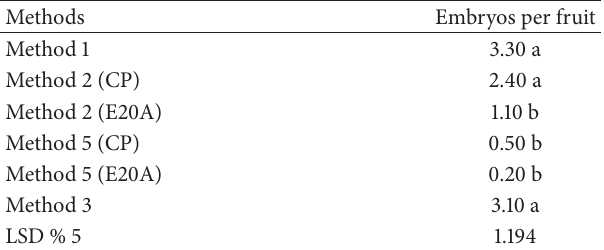
Table 2: Average embryo number per fruit obtained from different